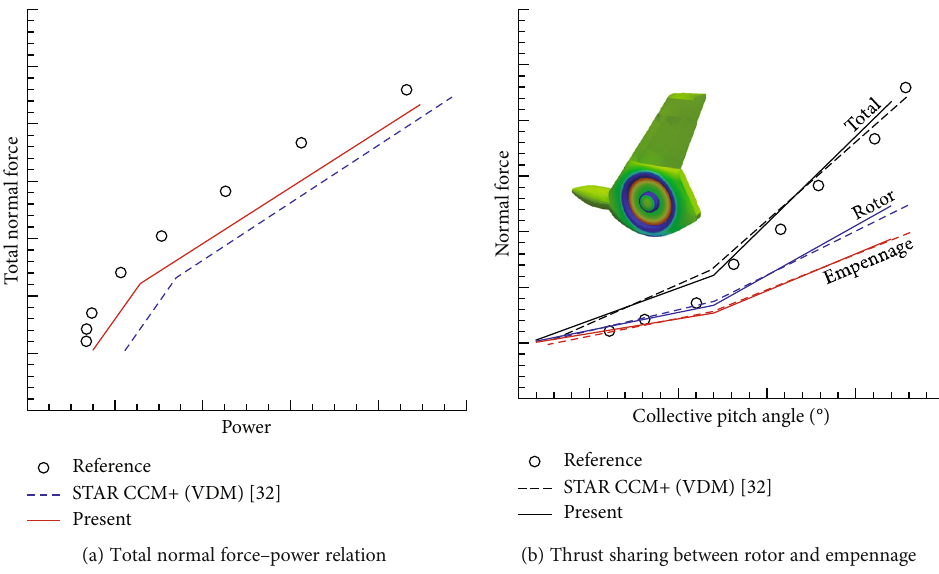
Figure 7: Aerodynamic performance of tail rotor. Table 2: Information on grid